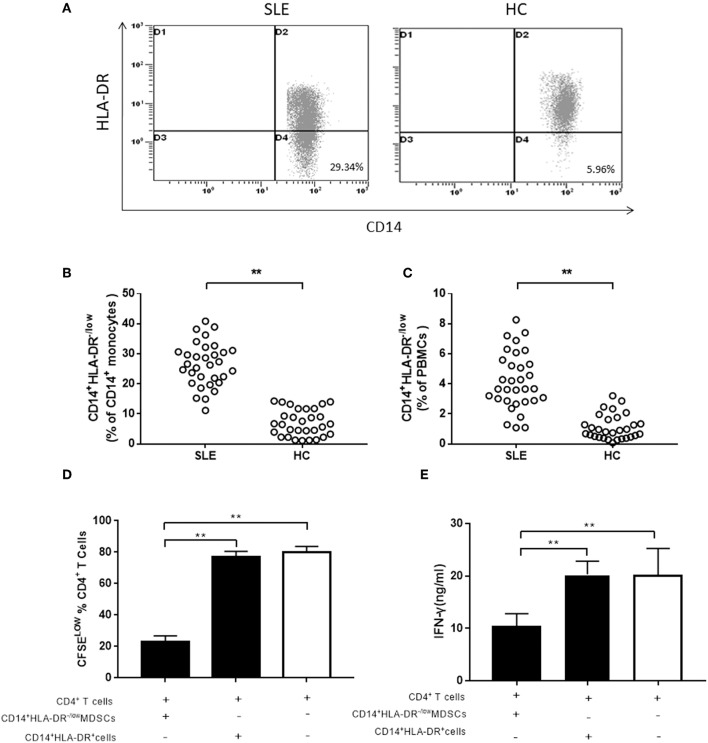
The expression of M-MDSCs in SLE patients. (A) Representative flow cytometric speckle maps showed the expression of M-MDSCs in newly diagnosed SLE patients and healthy controls. (B) M-MDSCs levels in newly diagnosed SLE patients and healthy controls (in CD14+ monocytes). (C) M-MDSCs levels in newly diagnosed SLE patients and healthy controls (in PBMCs). (D) MDSCs had a significantly immunosuppressive activity on CD4+T cells as compared to the CD14+HLA-DR+ cells from active SLE patients. The proliferation of CD4+T cells was measured by dilution of CFSE staining intensity using flow cytometry. (E) IFN-γ-producing was also significantly decreased in CD4+T cells co-cultured with M-MDSCs. Each point represents an individual. The horizontal bar represents the average. **P < 0.01.